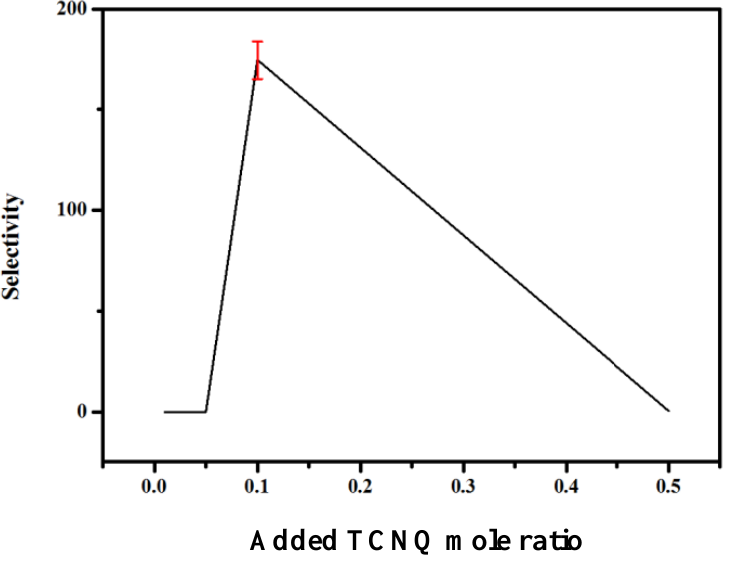
Figure 9. CO 2 /N 2 separation performance of PVP/CuO/TCNQ membrane according to TCNQ Table 1. Separation performance of neat PVP, PVP/CuO, and PVP/CuO/TCNQ composite mem- branes.